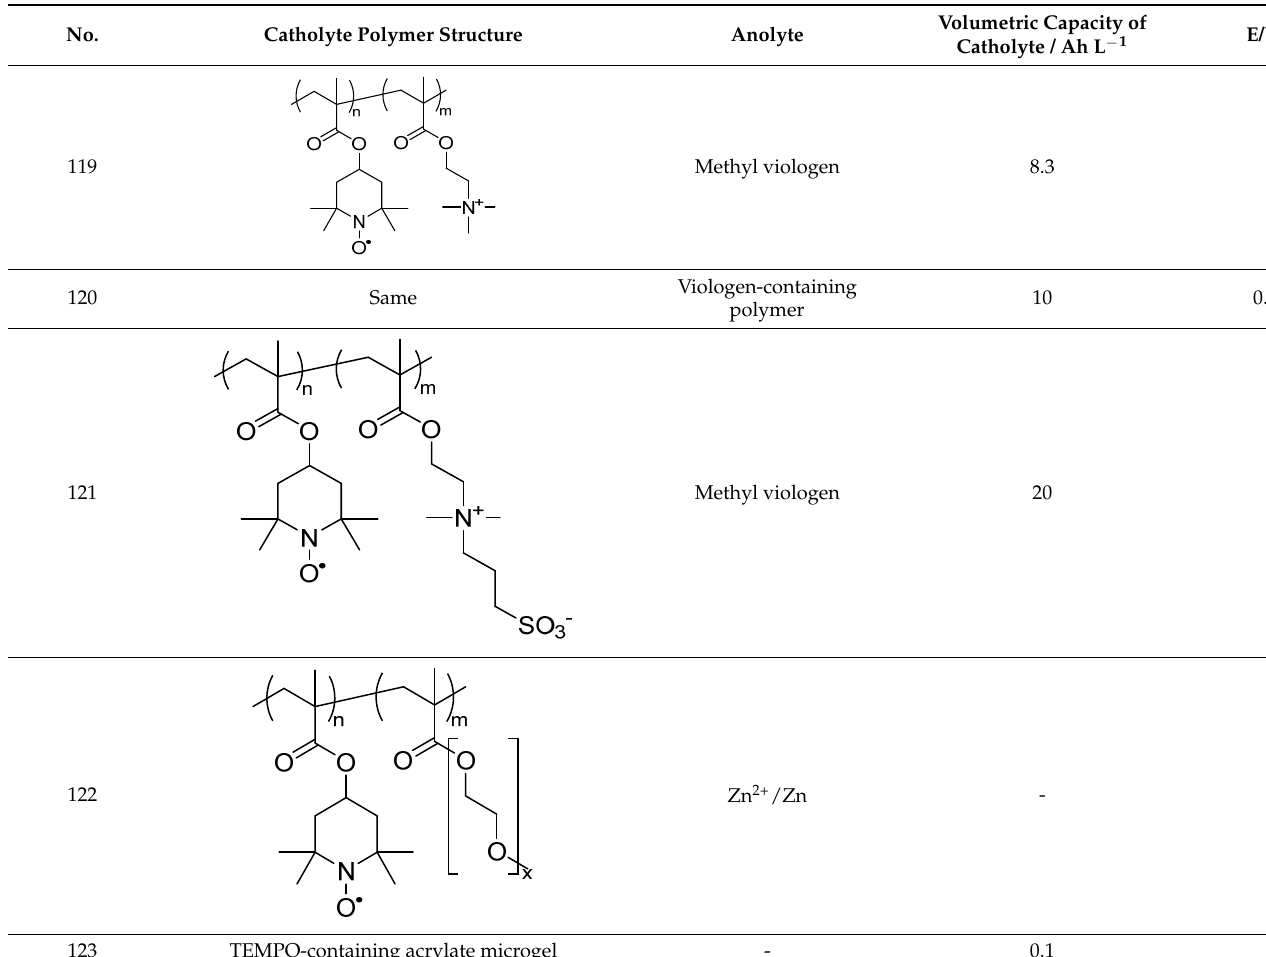
Table 3. Structures and energy storage performance of the TEMPO-polymeric catholytes for redox flow batteries.